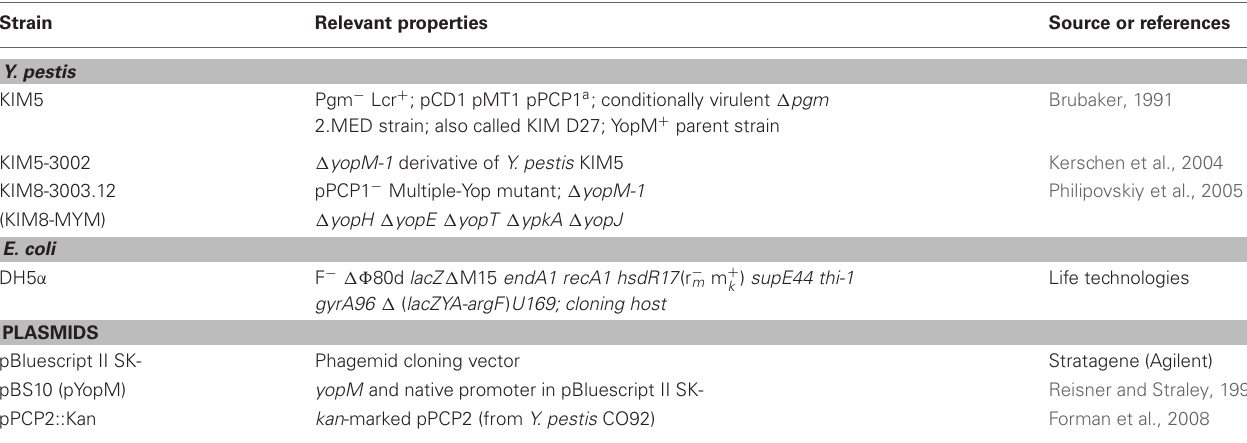
Table 1 | Bacterial strains and plasmids used in this